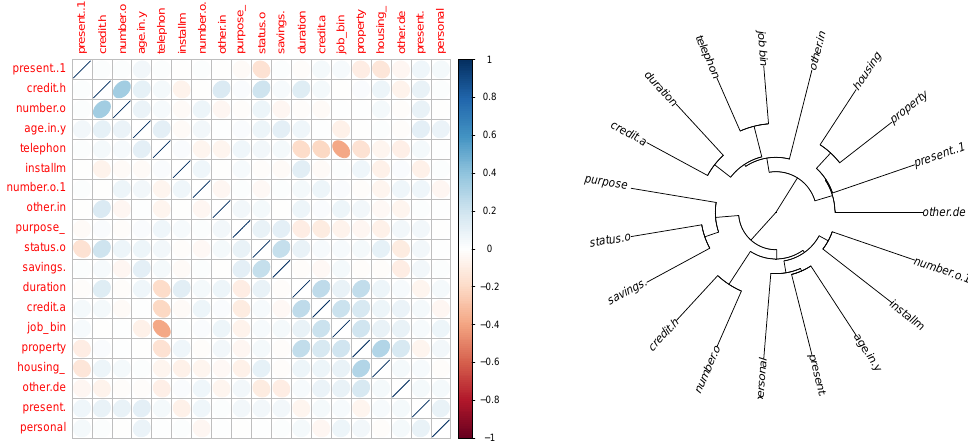
Figure 3. Reordered correlation matrix ( left ) and phylogenetic tree of the clustered variables ( right